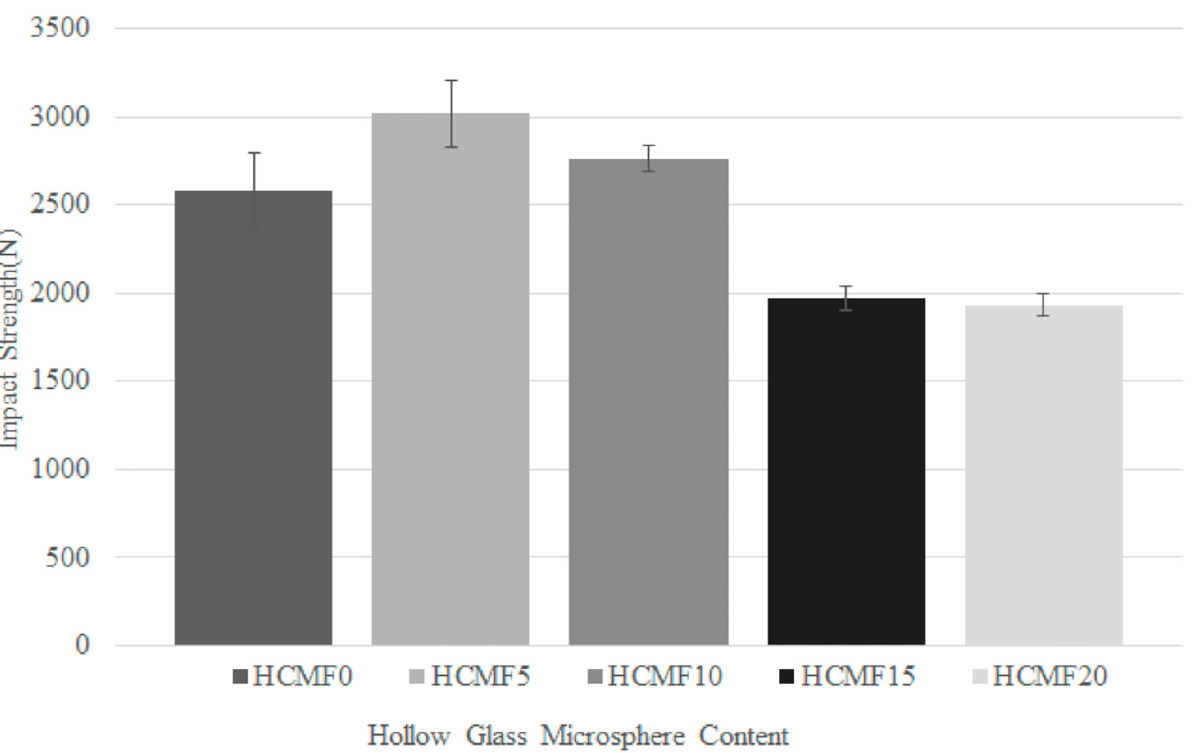
Figure 11. Impact resistance of HCMF composites as related to the HCM content.